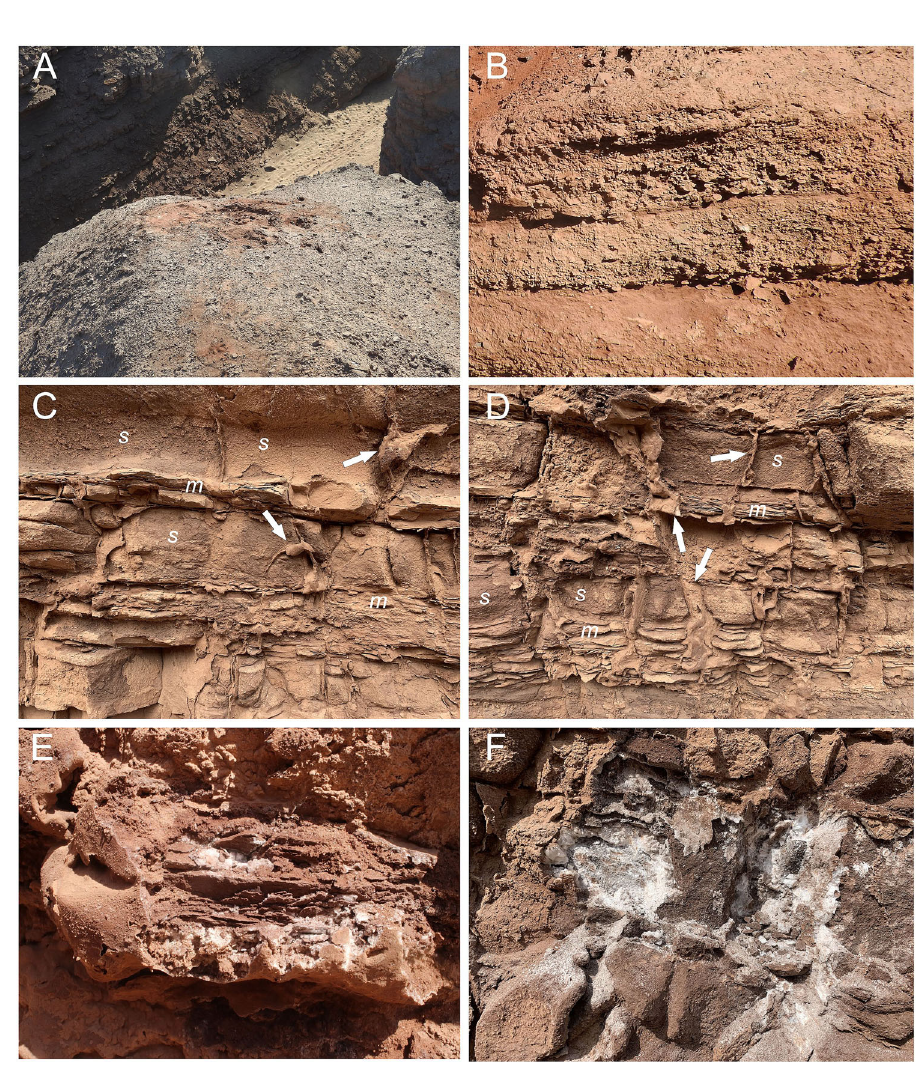
Fig. 3 | Close-up views of the studied outcrop. A Top weathered loose con- glomerates. B Cementedconglomerates. C , D Showsandstones(s)with fi nelayered mudstones (m). White arrows point to halite/gypsum veins. E One of the evaporite